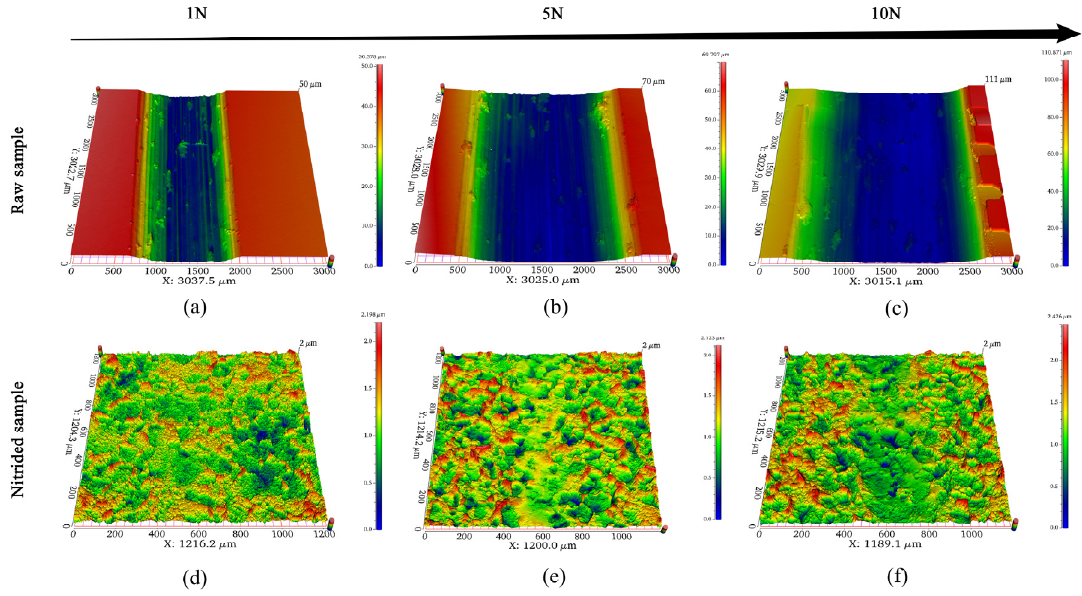
Figure 7. 3D wear morphology after the tribocorrosion test of the ( a–c ) raw sample and the ( d–f ) nitrided sample at OCP in SBF solution.